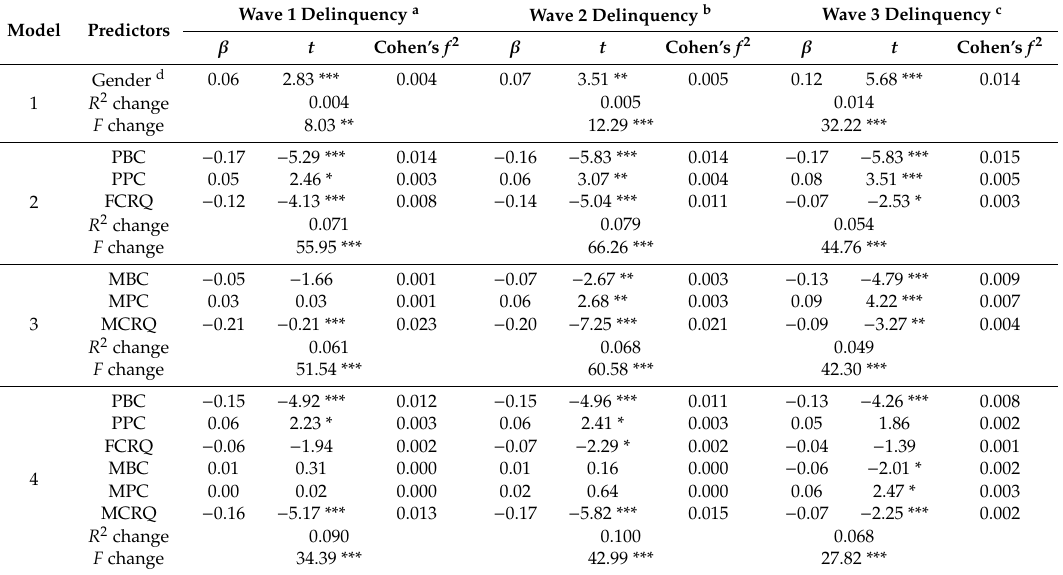
Table 8. Concurrent predicting e ff ects of parent-child subsystem qualities on delinquency. Wave 1 Delinquency a Wave 2 Delinquency b Wave 3 Delinquency Model Predictors